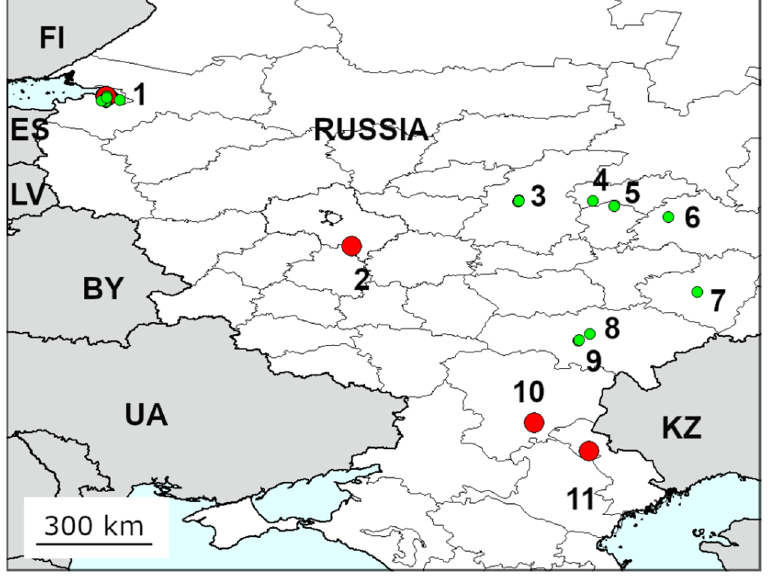
Figure 1. Surveyed sites of ash trees in European Russia in 2019–2020. Red circles—EAB is detected, green circles—EAB is not detected. 1—St. Petersburg City, 2—Kokinskij Forest nearby Ozherelie